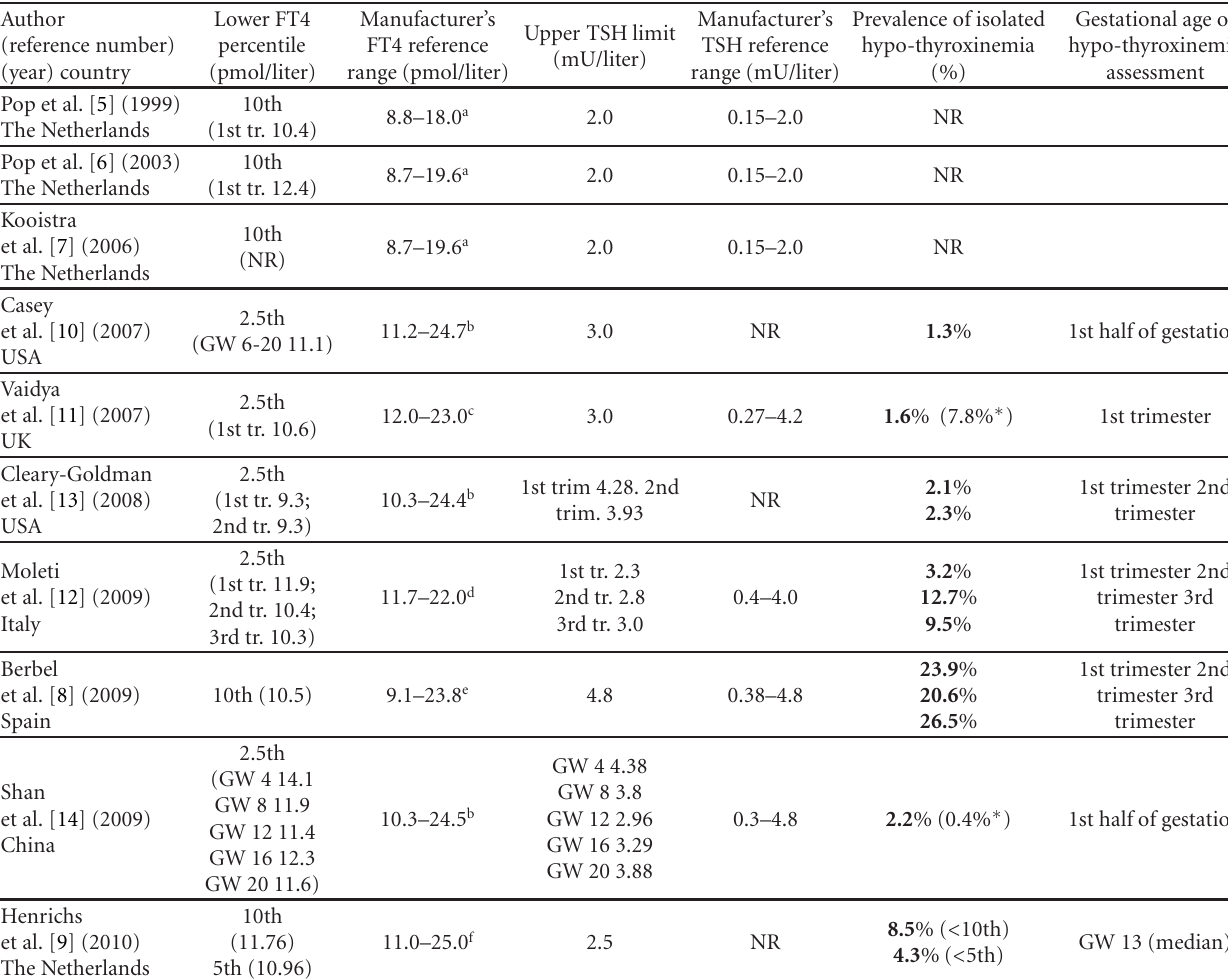
Table 1: Biochemical criteria used to define isolated maternal hypothyroxinemia and its epidemiological